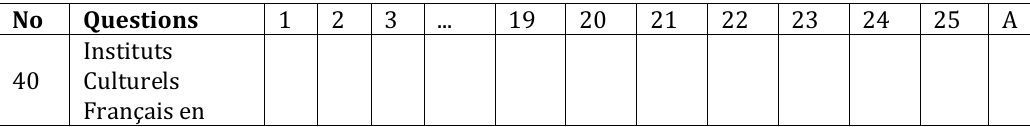
Tableu 1 Connaissance de bureau culturelle en